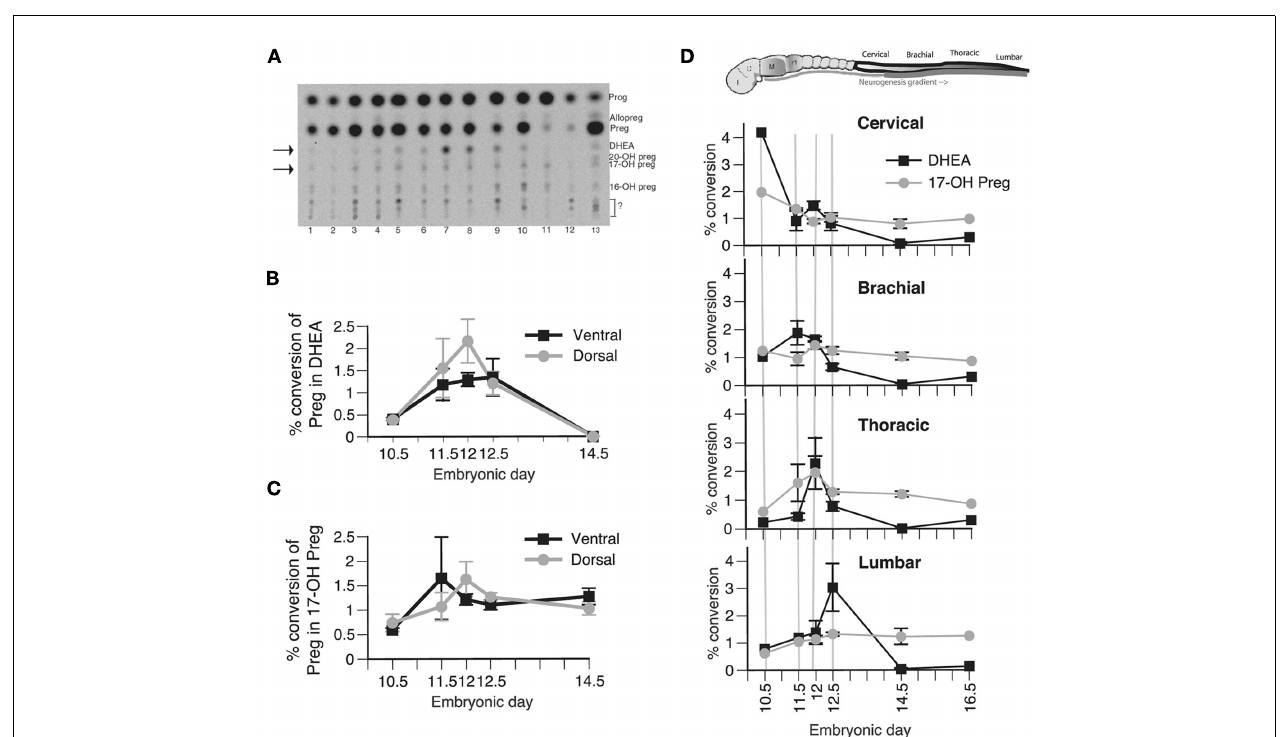
FIGURE 2 | Biosynthesis of steroid products derived from P450c17 activity in vivo in the developing spinal cord. (A) TypicalTLC plate from E12.5 embryos. 1: spinal cord (SpC) cervical ventral, 2: SpC cervical dorsal, 3: SpC brachial ventral, 4: SpC brachial dorsal, 5: SpC thoracic ventral, 6: SpC thoracic dorsal, 7: SpC lumbar ventral, 8: SpC lumbar dorsal, 9: genital ridge, 10: DRG, 11: notochord, 12: mesenchyme, 13: brain. Preg, pregnenolone; Prog, progesterone. Arrows point to DHEA and 17-OH pregnenolone. (B,C) Biosynthesis of DHEA (B) and 17-OH pregnenolone (C) was determined in the ventral (black line) and dorsal portion (gray line) of the brachial–thoracic segment of the spinal cord sampled at E10.5, E11.5, E12, E12.5, and E14.5. A general factorial analysis was performed to assess the significance of the position of the sample along the ventro-dorsal axis and the embryonic age on either the percent conversion of pregnenolone into DHEA or 17-OH pregnenolone. No difference was found. (D) Biosynthesis of DHEA